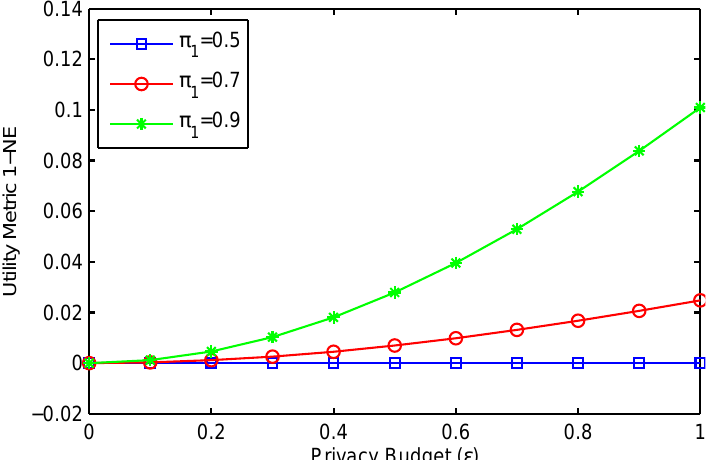
Figure 10. Utility metric 1 − NE of output of bivariate randomized response